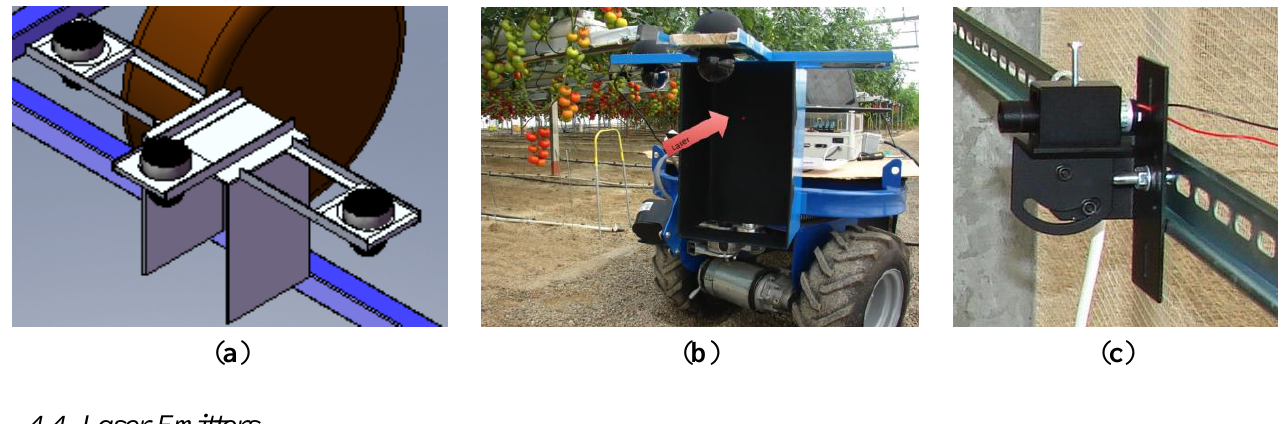
Figure 7. ( a , b ) Camera mounting platform in the front part of the vehicle. [20] Note the red laser point in the front dartboard. ( c ) Laser emitter installed in a